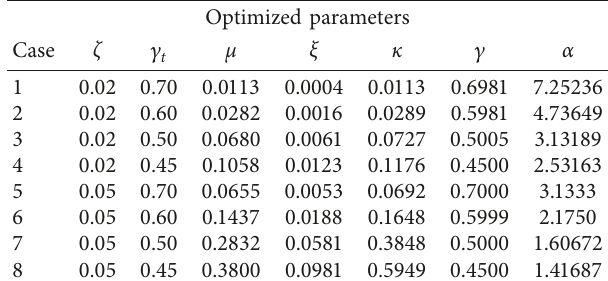
Table 5: Design optimization parameters of the structure with the inerter system based on the modified harmony search algorithm.